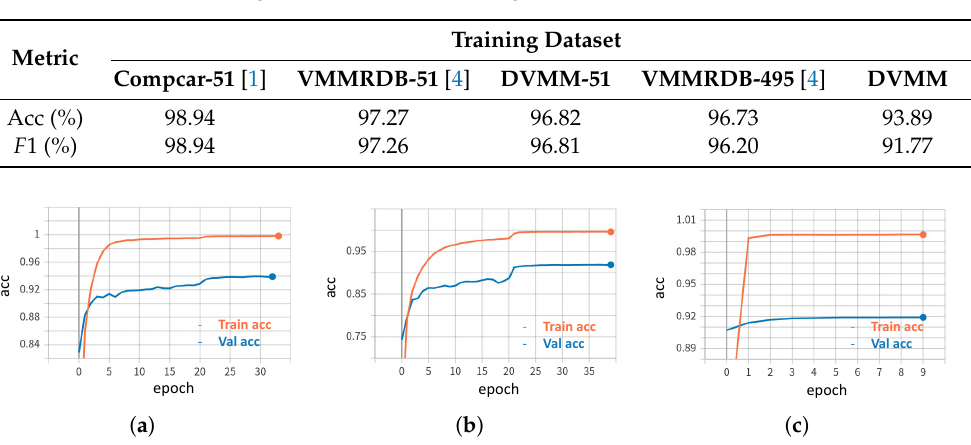
Table 5. Vehicle make recognition results for 1B using a DenseNet201 [17] backbone.